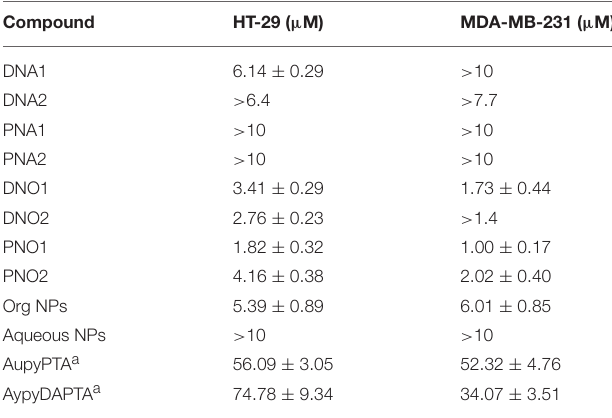
TABLE 2 | IC 50 values of the different hybrid systems and corresponding